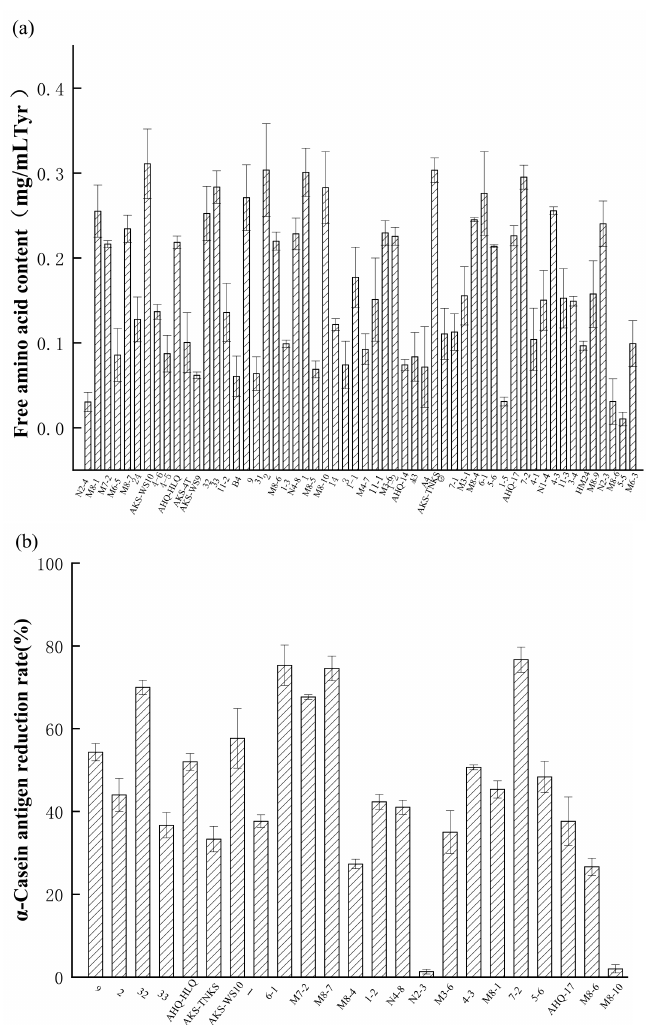
Figure 1. ( a ) Free amino acid content of skim milk fermented by 56 strains of bacteria. ( b ) Antigenic changes of α -casein in 23 strains of